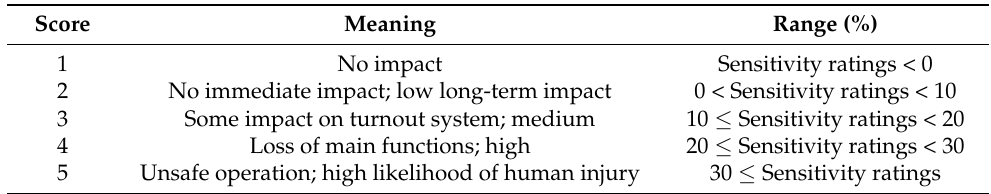
Table 6. Sensitivity score estimation